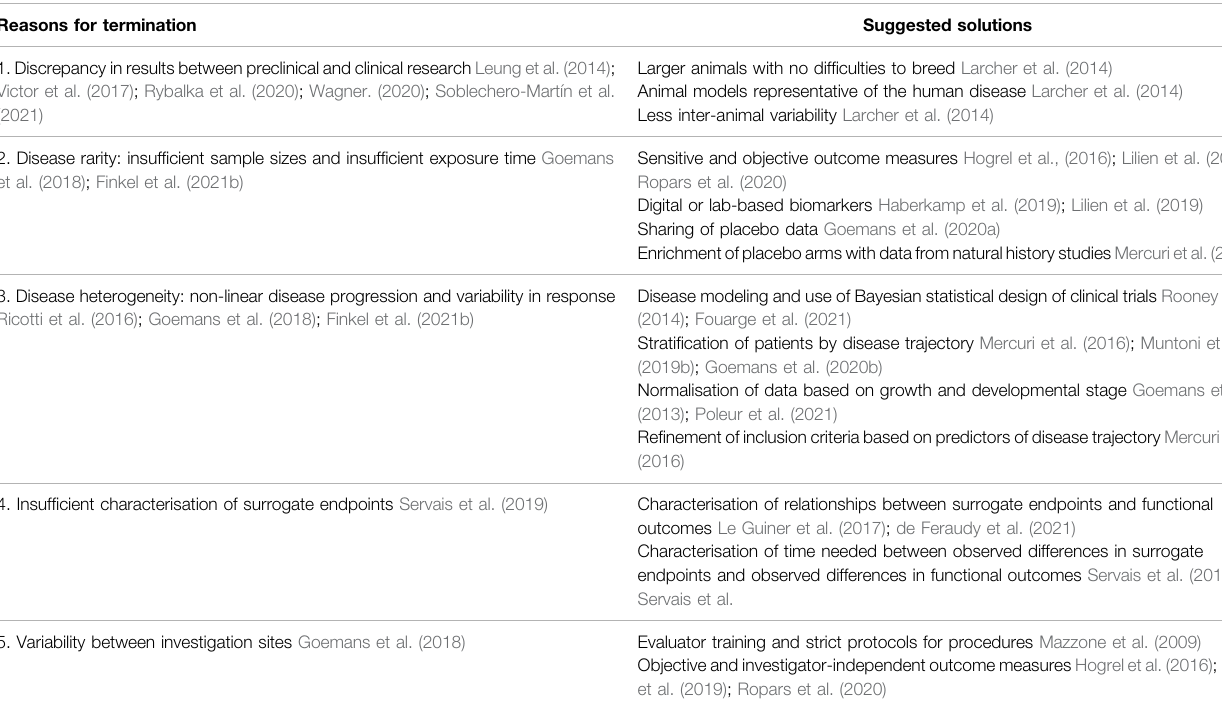
TABLE 2 | Reasons for termination and suggested